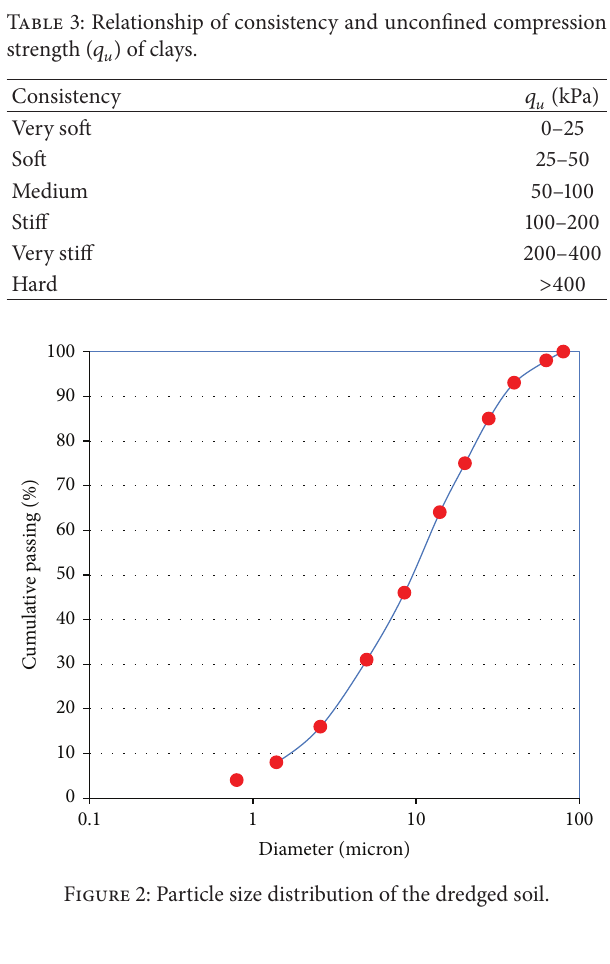
Table 3: Relationship of consistency and unconfined compression